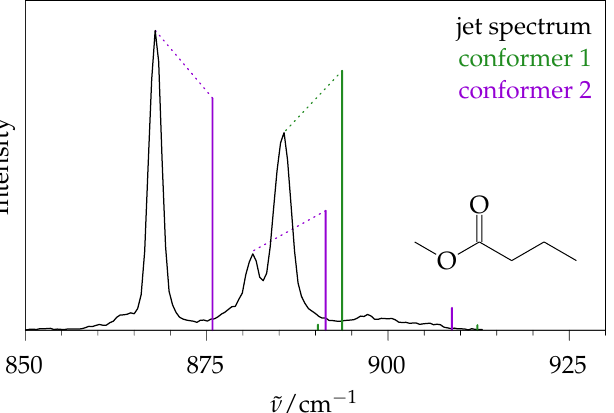
Figure 2. Enlarged part of a Raman jet spectrum of methyl butanoate (line) and calculated harmonic Raman spectrum for its two main conformers (vertical bars encoding predicted wavenumber and integrated intensity). Although a qualitative assignment is directly possible by implying a systematic anharmonic downshift, a quantification by signal integration is not, because the baseline does not drop to zero between the signals.